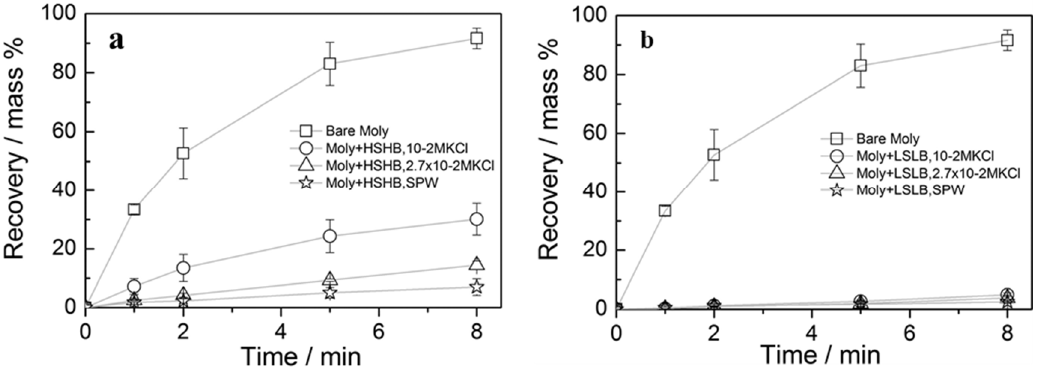
Figure 6. Single-mineral flotation of bare molybdenite and in presence of 5 mg/L CMC (( a ) HSHB and ( b ) LSLB) at three studied electrolyte conditions: 10 –2 M KCl, 2. 76 × 10 –2 M KCl, and SPW, all at pH 9 (reprinted with permission from Kor et al. [35], copyright (2014) American Chemical Society).